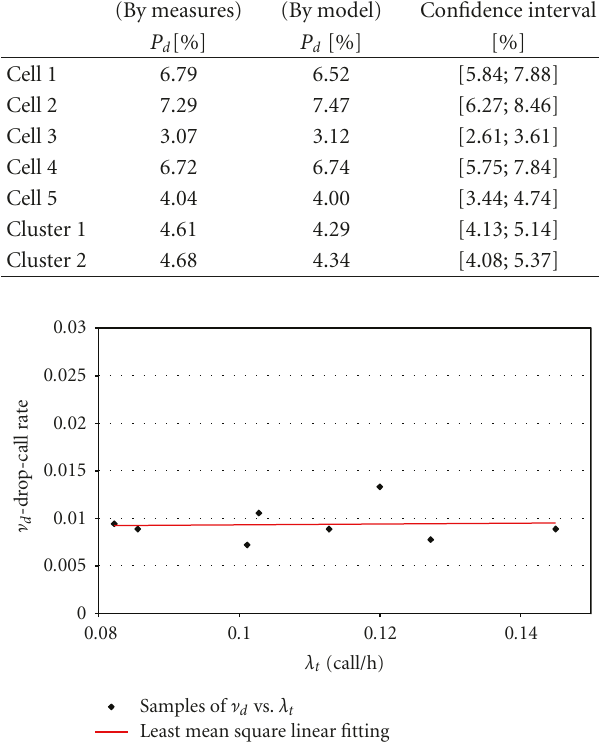
Table 3: Drop-call probability results. (By measures) (By model) Confidence interval